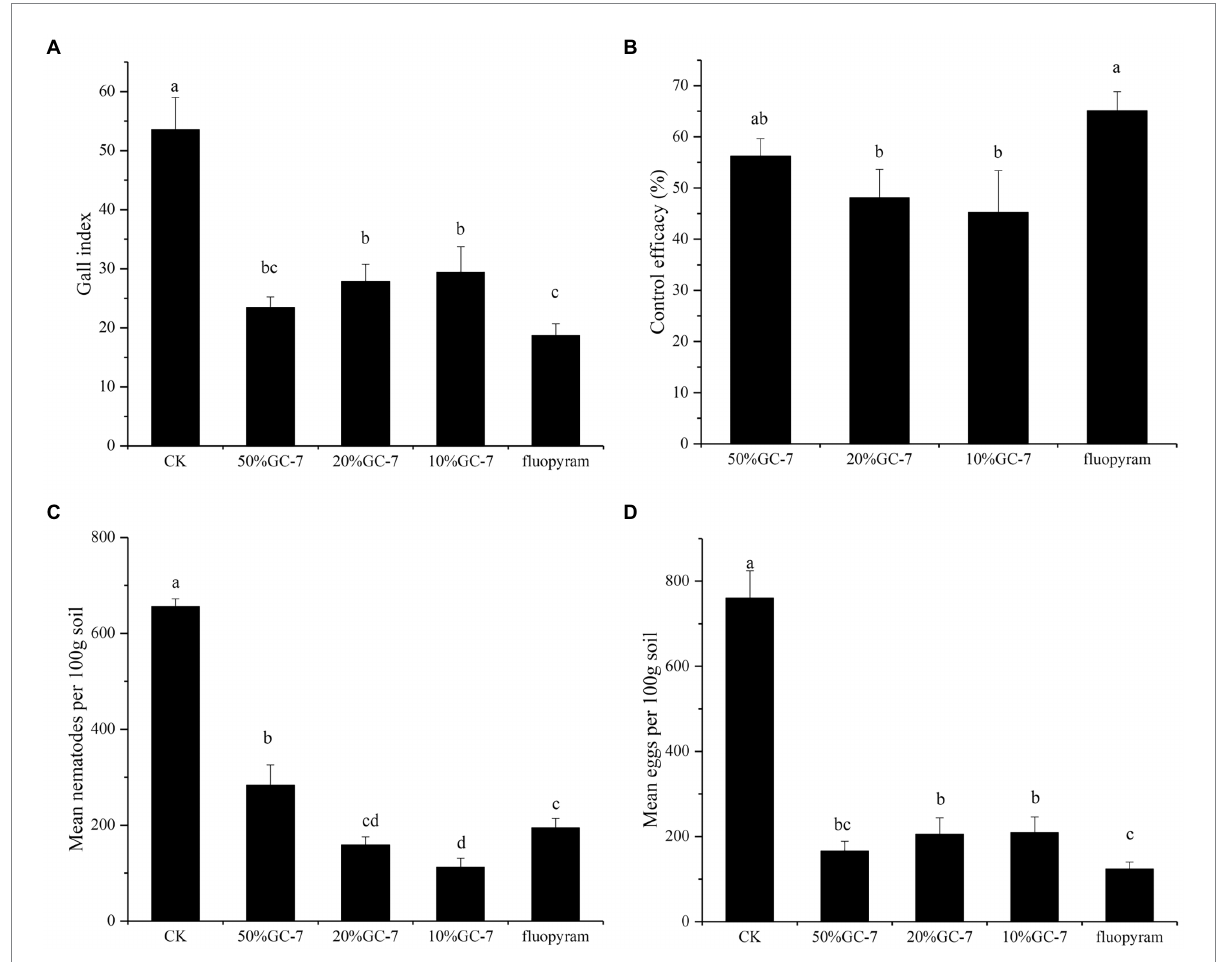
FIGURE 4 Biocontrol of M. graminicola in the pot-based experiment. (A) Gall index of GC-7 against M. graminicola in the pot-based experiment. (B) The control efficacy in different treatments. (C) Effects of the application of GC-7 on the final nematodes in soil. (D) Suppression of M. graminicola eggs by GC-7 in soil of pot-based experiment under greenhouse conditions. Each pot contains five two-leaf stage rice seedings, fourty millilitre of the different concentrations of the bacterial fermentation broth was applied as irrigation to each pot. The control were treated with sterilized water or fluopyram. Two days after inoculation with the bacterial fermentation broth, 2 ml of M. graminicola suspension (750 vigorous J2s/mL) was drenched into each pot. Vertical bars represent standard deviation of the mean values. Tukey’s multiple range test was employed to test for significant differences between treatments at p < 0.05. Different lowercase letters indicate significant difference between treatments ( p <